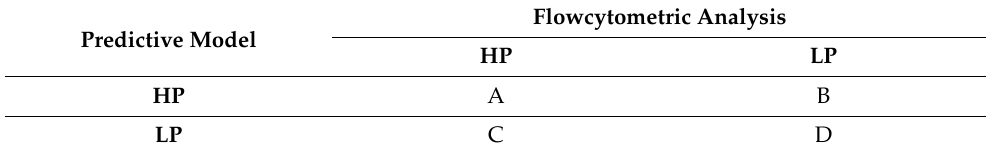
Table 1. The confusion matrix (2 × 2 table).